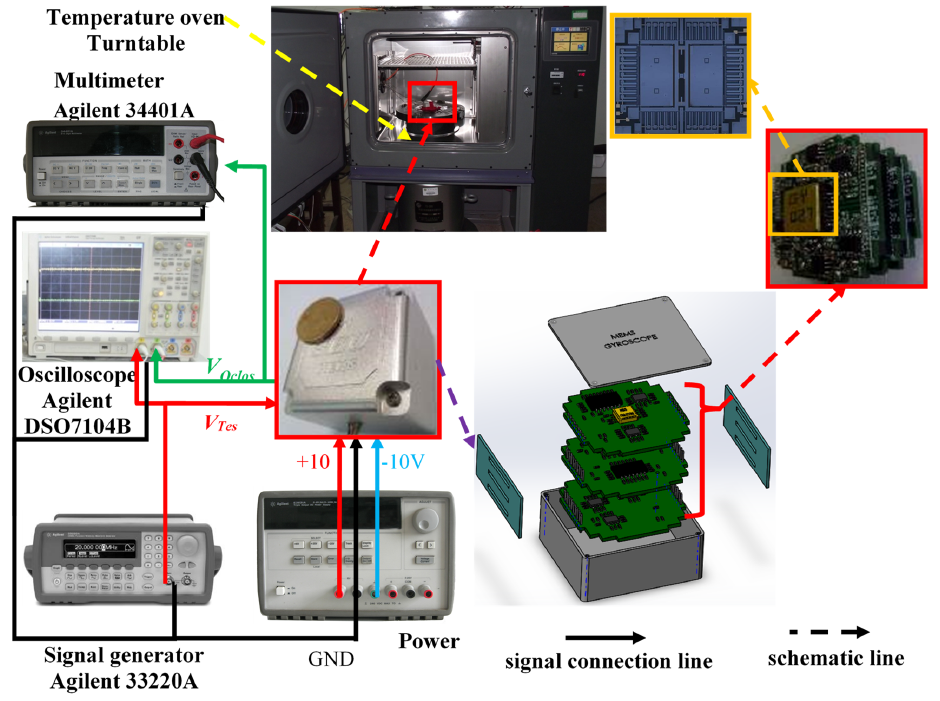
Figure 9. Temperature experiment device.